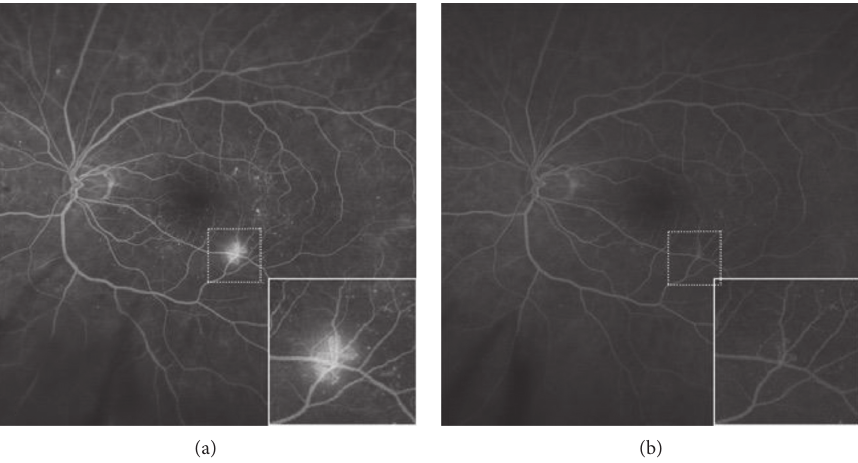
Figure 4: Diabetic neovascularization (NV) of the left eye of a 59-year-old patient with newly diagnosed proliferative diabetic retinopathy on both eyes, with the NV magnified equally (a, b). Initial imaging shows a densely interlaced vascular pattern of the NV with leakage (a) and follow-up imaging after four monthly anti-VEGF injections shows a regressed truncated vascular pattern of the NV without leakage (b), equivalent to column D in Figure 5.